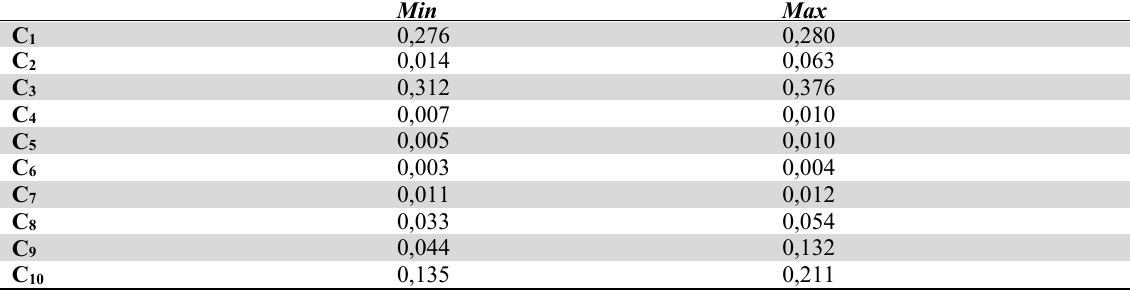
Range limits for criteria